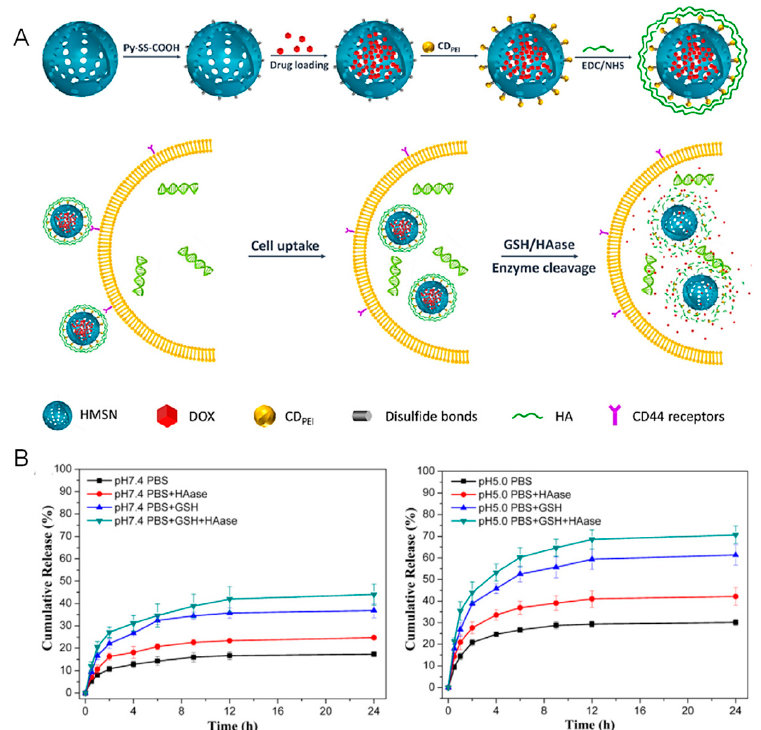
Figure 8. ( A ) Schematic representation of the synthesis of the nanosystem as well as of the mechanism of cellular uptake and triggering of drug release. ( B ) Release experiments in the presence or absence of GSH and hyaluronidase that show that the highest release took place upon application of both stimuli. Reproduced with permission from [53]. Copyright Elsevier, 2017.